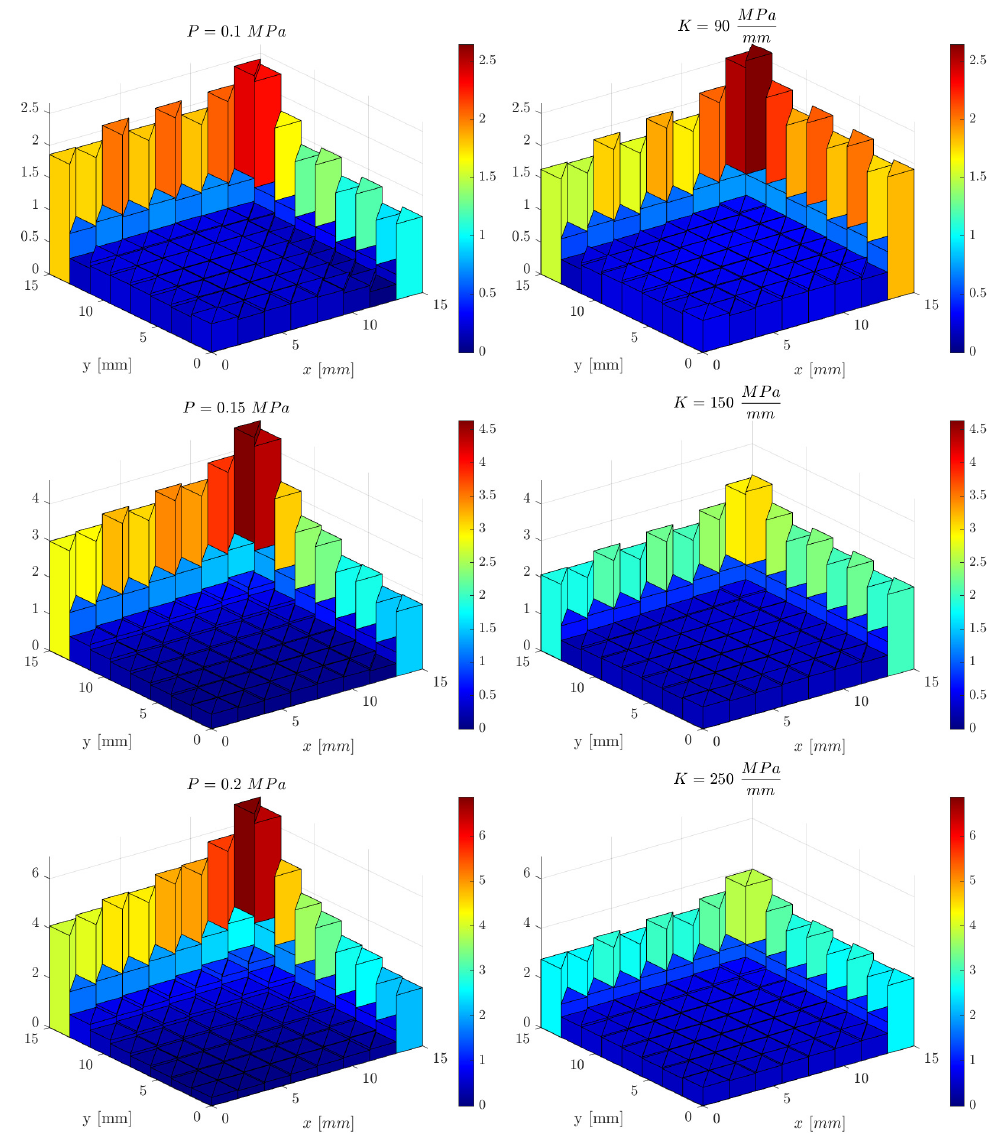
Figure A1. Complete normal contact traction ( t n for the uniform clamping pressure and Winkler elastic